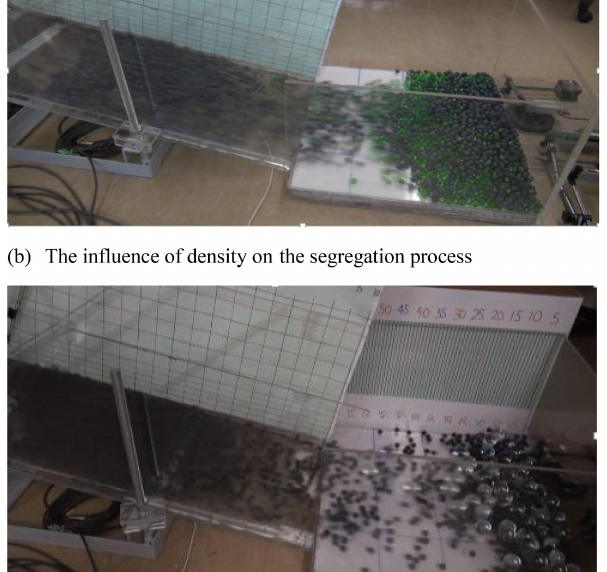
character of the flow mass where the Savage number is